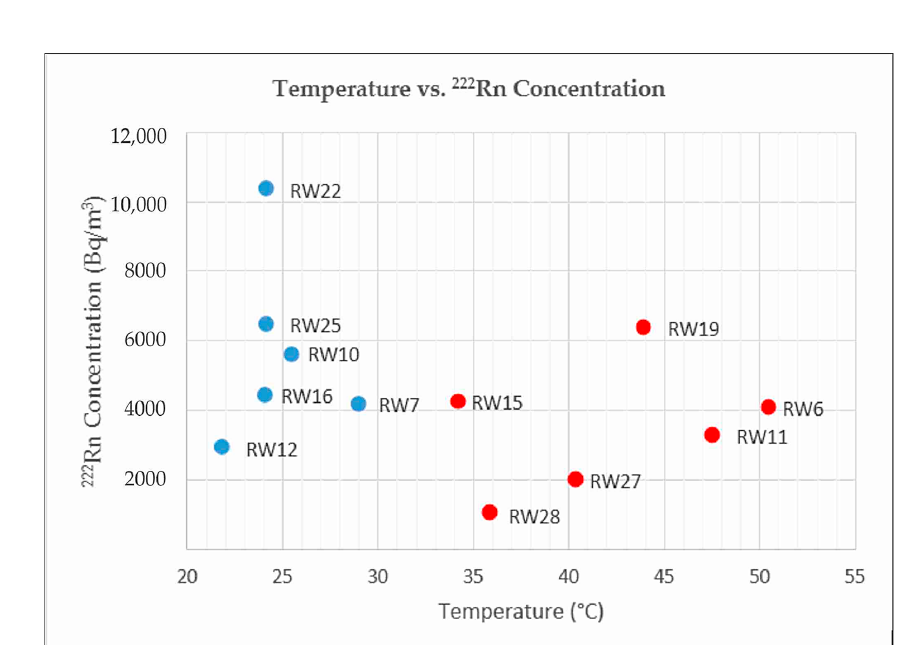
Figure 15. Graphic of thermal and cold spring temperatures versus the 222 Rn concentration. Red represents thermal springs, and blue represents cold springs.